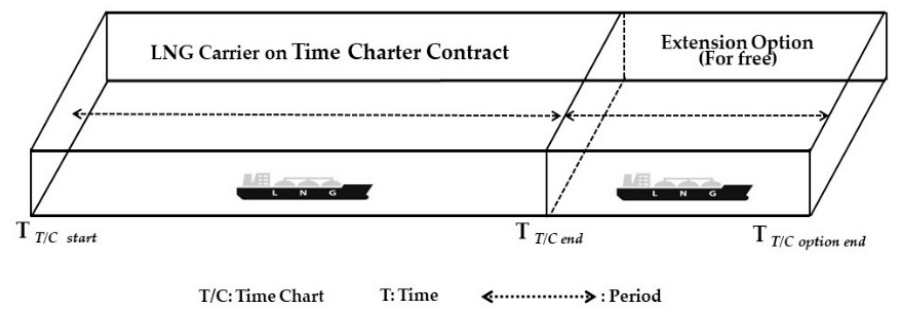
Figure 1. Structure of the T/C extension option.